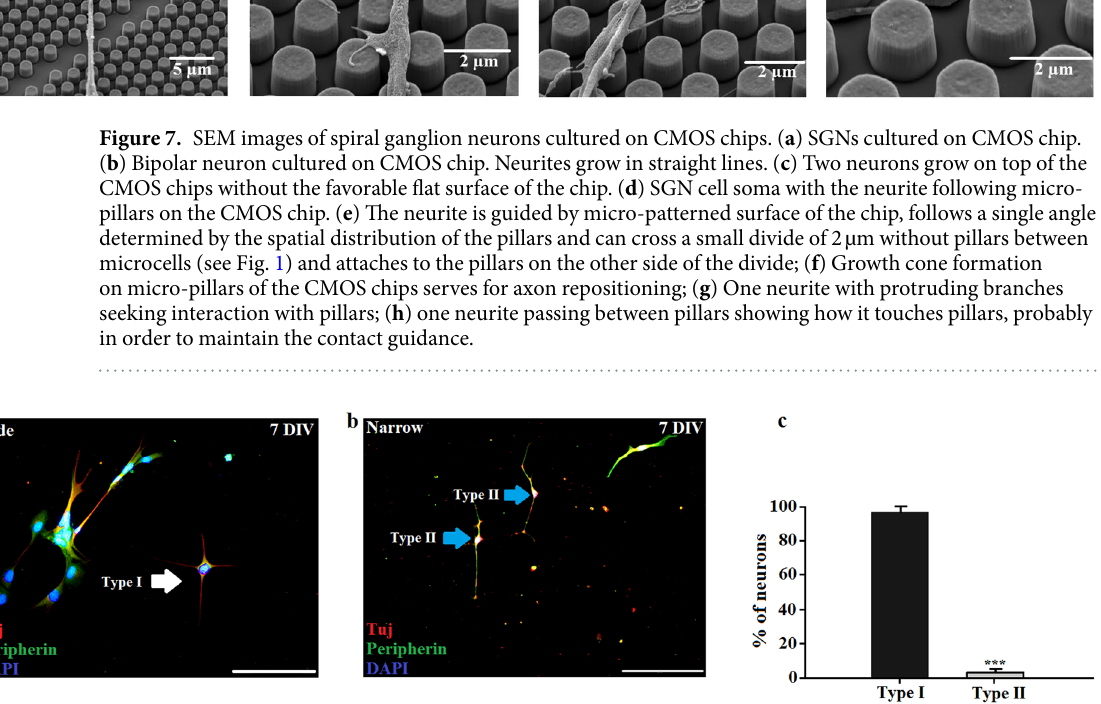
between pillars in mostly a single direction with occasional perpendicular branching. Neurites on pillars also formed a nerve growth cone which filopodia utilize as anchoring points for axon repositioning when on the CMOS pillar.